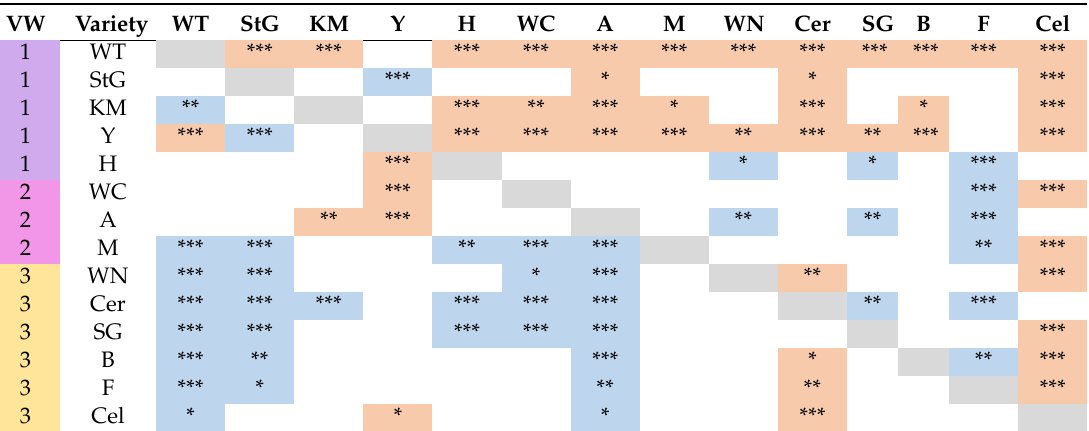
Table 2. Comparisons of average total polyphenols in hop stems before flowering (BBCH stage 51–55; table—top triangle above grey-boxed area) and at the mature cones stage (BBCH stage 87–89; table—bottom triangle below grey—boxed